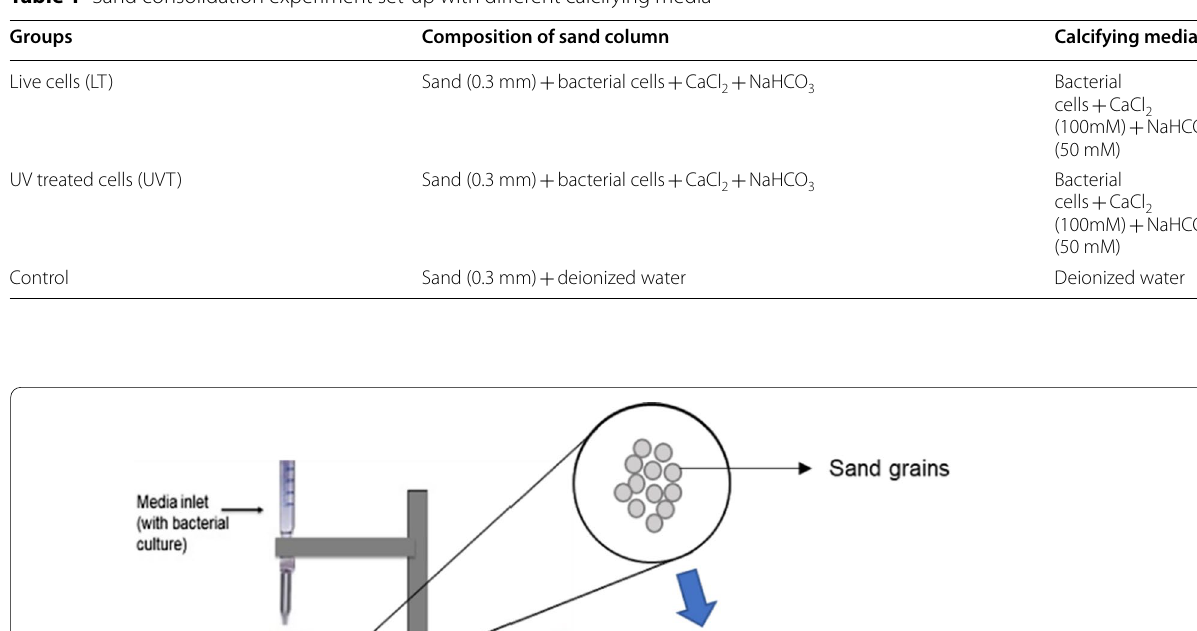
Table 1 Sand consolidation experiment set-up with different calcifying media